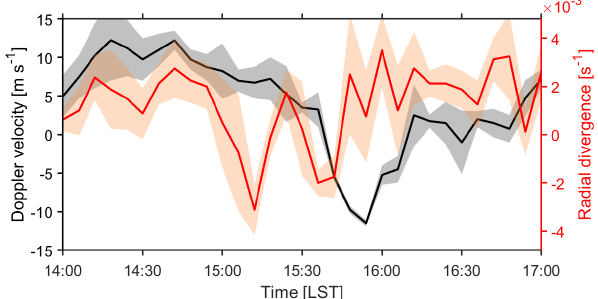
Figure 6. Doppler velocity (left axis) and radial divergence (right axis) observed over the Zhengzhou national reference climatologi- cal station. Thick lines and shaded areas indicate the respective me- dian values and standard deviations at elevation angles of 1.5, 2.4, 3.3, and 4.3 ◦